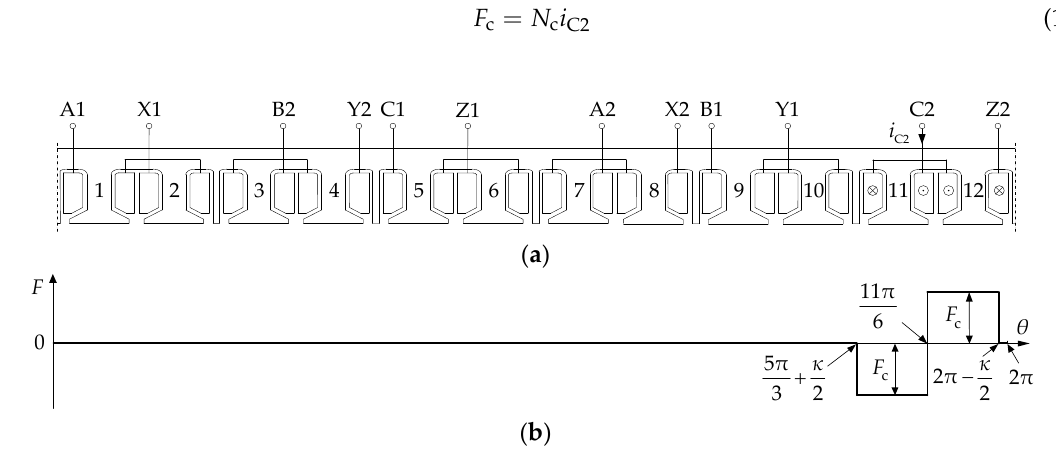
Figure 5. The MMF of the C2 phase winding under normal conditions: ( a ) The stator winding outspread diagram; ( b ) The distribution diagram of the MMF generated by i C2